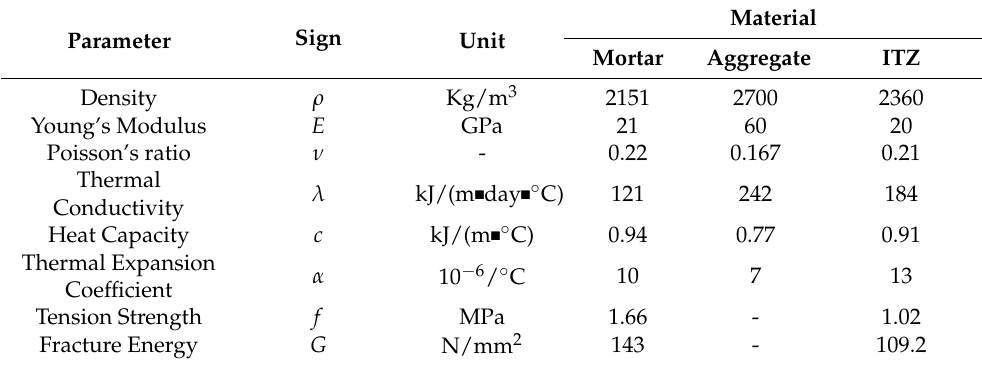
Table 3. Meso material parameters of multiscale macro–meso model.